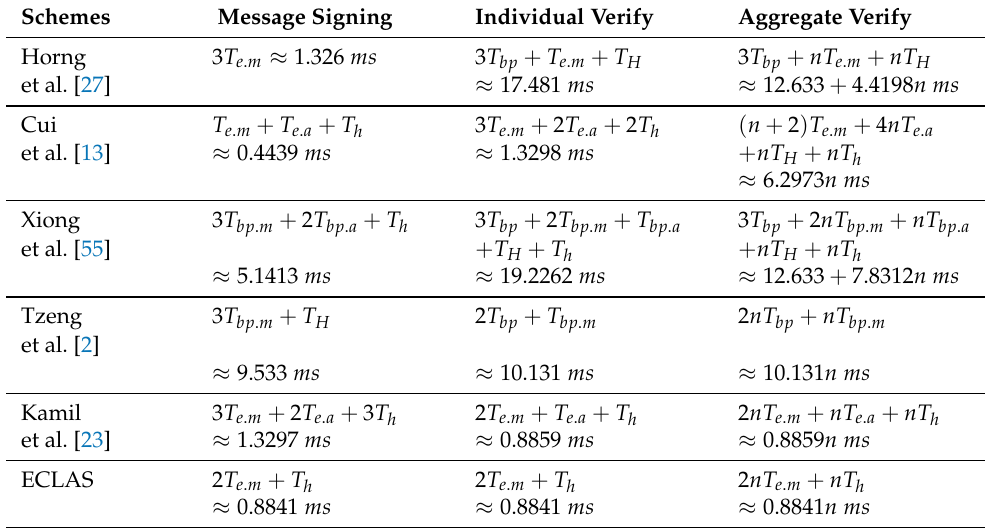
Table 4. Comparison of Computation Costs for Related Certificate-less aggregate signature (CLAS) Schemes in ms